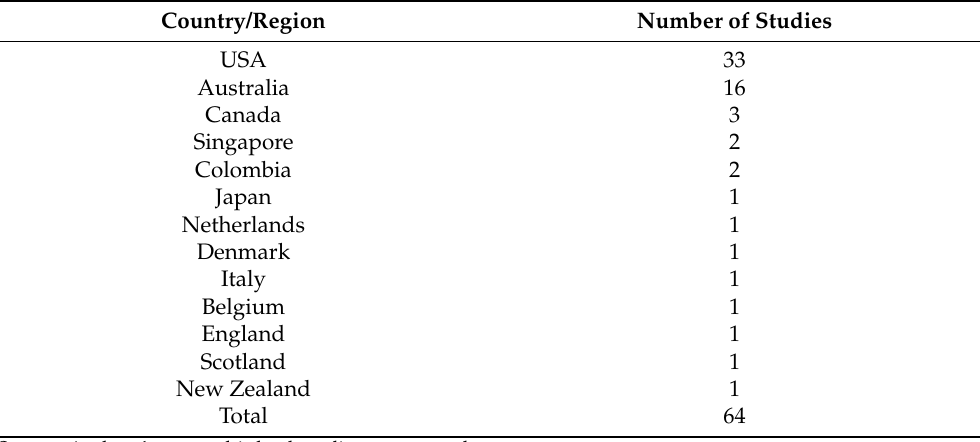
Table 1. Geographical coverage of selected peer-reviewed publications.